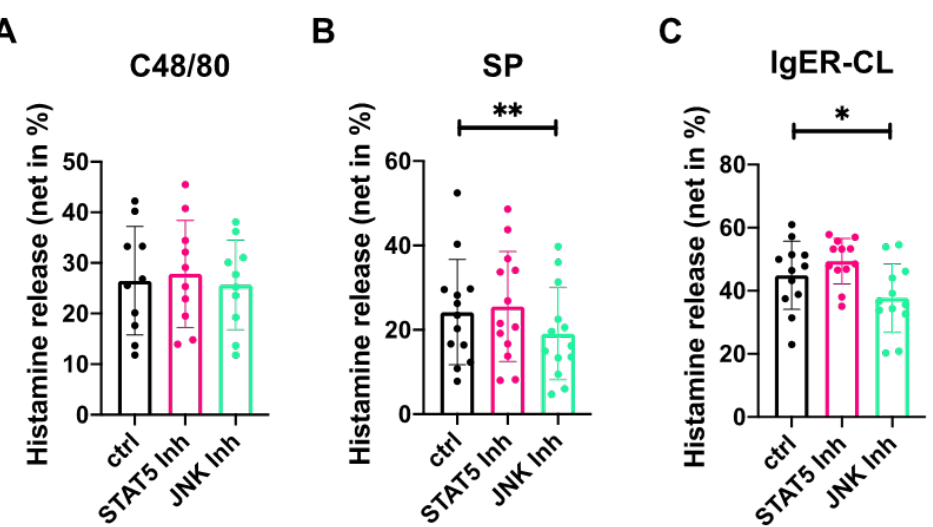
Figure 4. Inhibition of JNK slightly interferes with degranulation triggered by SP or FcεRI aggregation, while STAT5 perturbation has no effect. MCs were pretreated with the JNK inhibitor SP600125 (5 µM), the STAT5 inhibitor Pimozide (5 µM) or no inhibitor (buffer control) for 15 min, then stimulated with ( A ) c48/80 (10 µg/mL); ( B ) SP (30 µM); ( C ) IgER-CL (AER-37, 0.2 µg/mL) for 30 min. The net histamine release is given as mean ± SD of 10-13 independent experiments. * p < 0.05, ** p < 0.01.